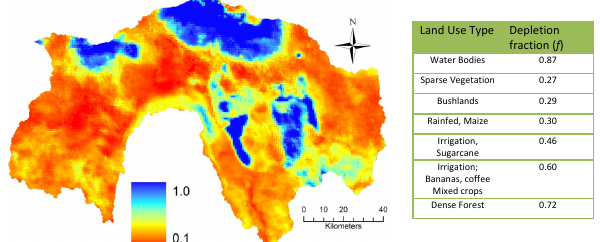
Figure 3. Soil moisture depletion fraction (defined using average values of the dry month of January of 2008, 2009 and 2010) in the upper Pangani River basin for selected land use